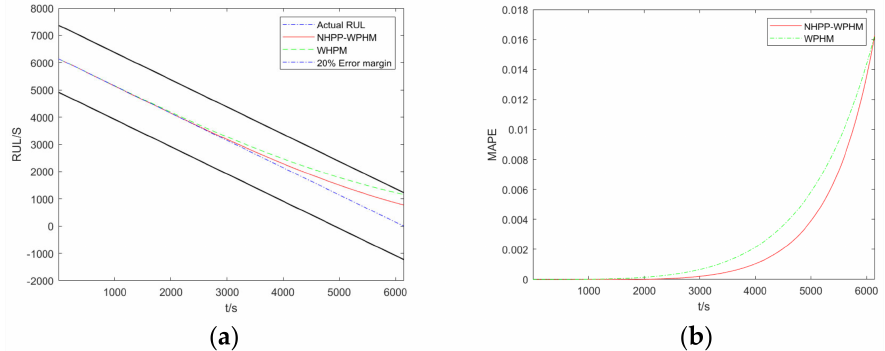
Figure 10. ( a ) RUL prediction results of two models; ( b ) MAPE of two models.